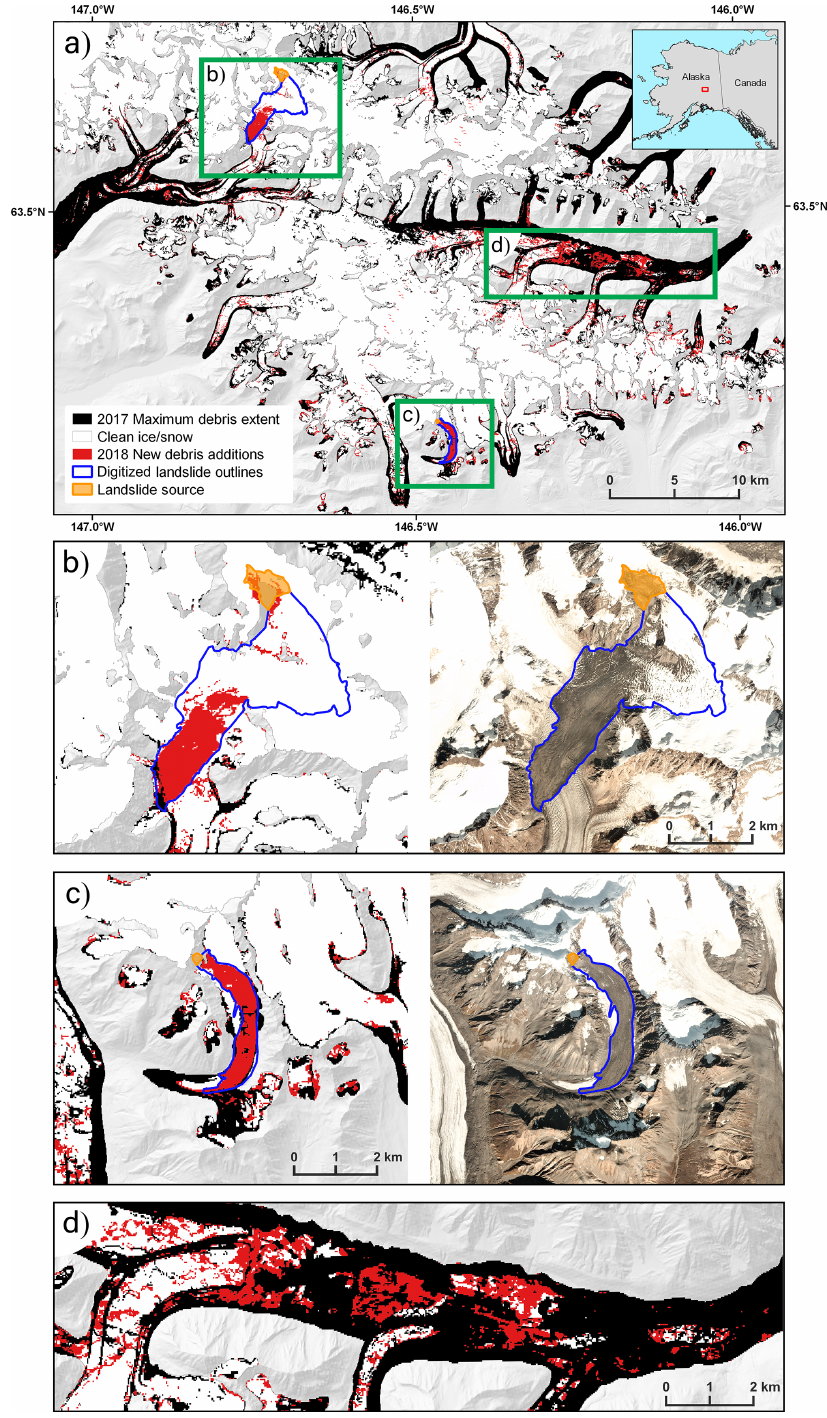
Figure 4. (a) The 2018 new debris additions in the Hayes Range, Alaska. RA outlines digitized using Landsat imagery and the GEEDiT tool (Lea, 2018). The inset map denotes the location of Hayes Range. (b) GERALDINE output of the Mt Hayes landslide extent and corresponding image courtesy of Planet Labs, Inc. (31 July 2018). (c) GERALDINE output of landslide extent on a small valley glacier east of Maclaren glacier and corresponding image courtesy of Planet Labs, Inc. (13 September 2018). (d) Erroneous 2018 tool detection of Black Rapids glacier RA deposits, which were deposited as a cause of the 2002 Denali earthquake (Jibson et al., 2006). Green boxes signify areas of interest and correspond to magnified areas of (b) , (c) , and (d) . IFSAR DTM background from the Alaska Mapping Initiative